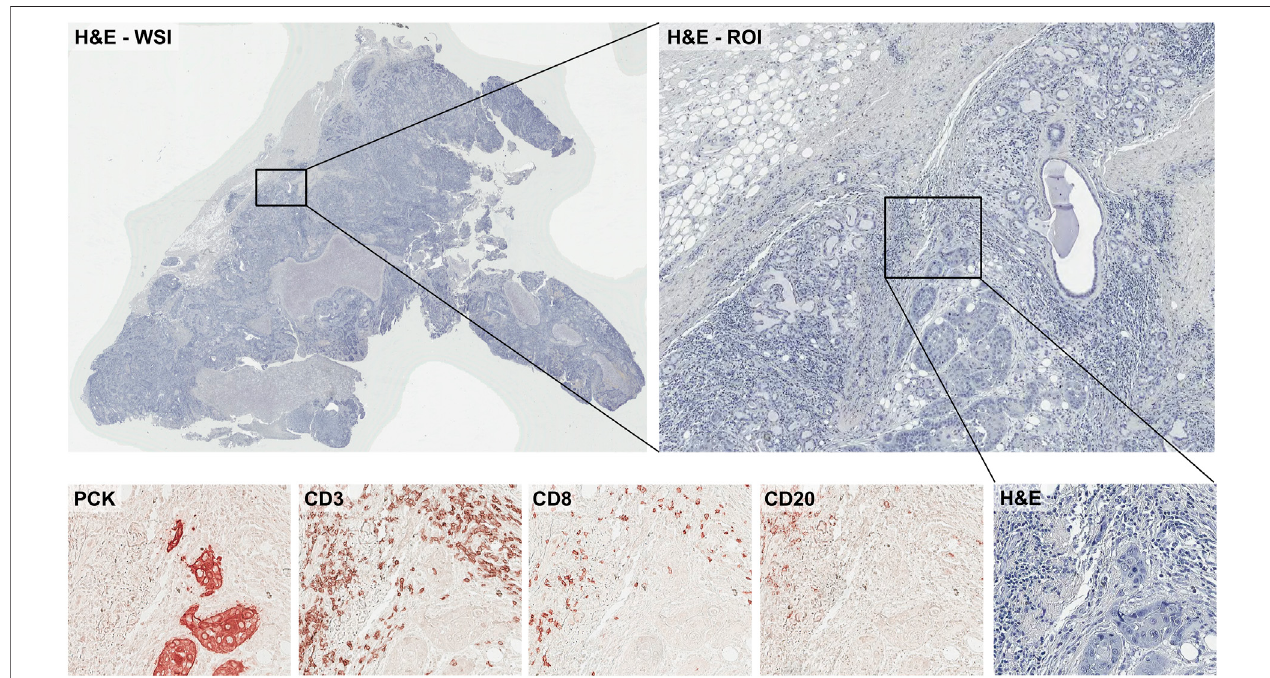
FIGURE 3 | Example of the IHC-stained histopathology images with different